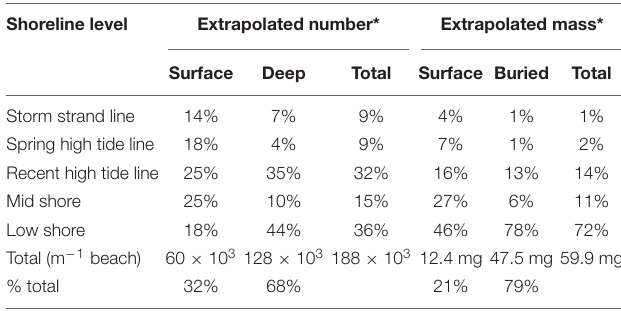
TABLE 4 | The proportions of microfibers at different levels on the shoreline and at two depth strata in 2017, expressed in terms of the number and mass of fibers. Shoreline level Extrapolated number* Extrapolated mass*